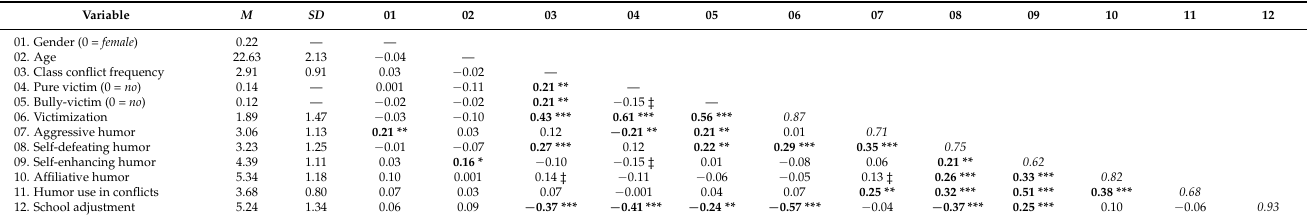
Table 1. Descriptive statistics and bivariate correlations of the study